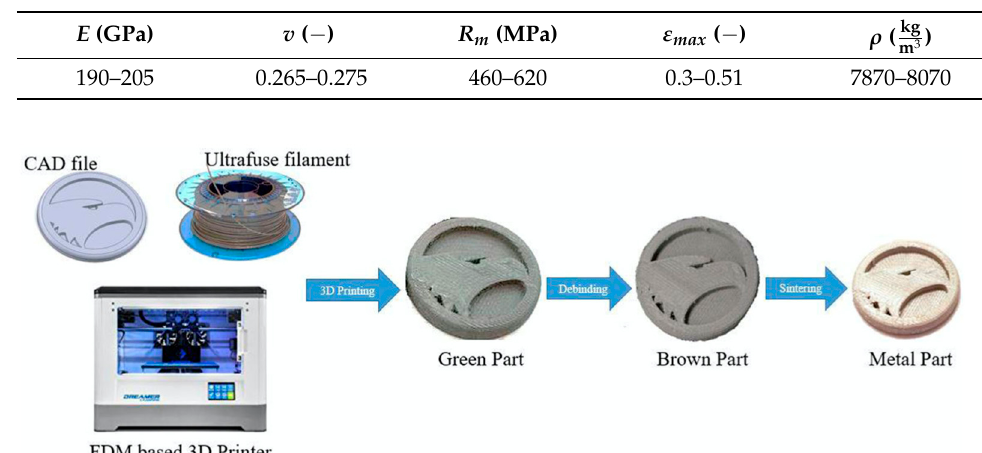
Table 1. Material properties of 316L steel [9].